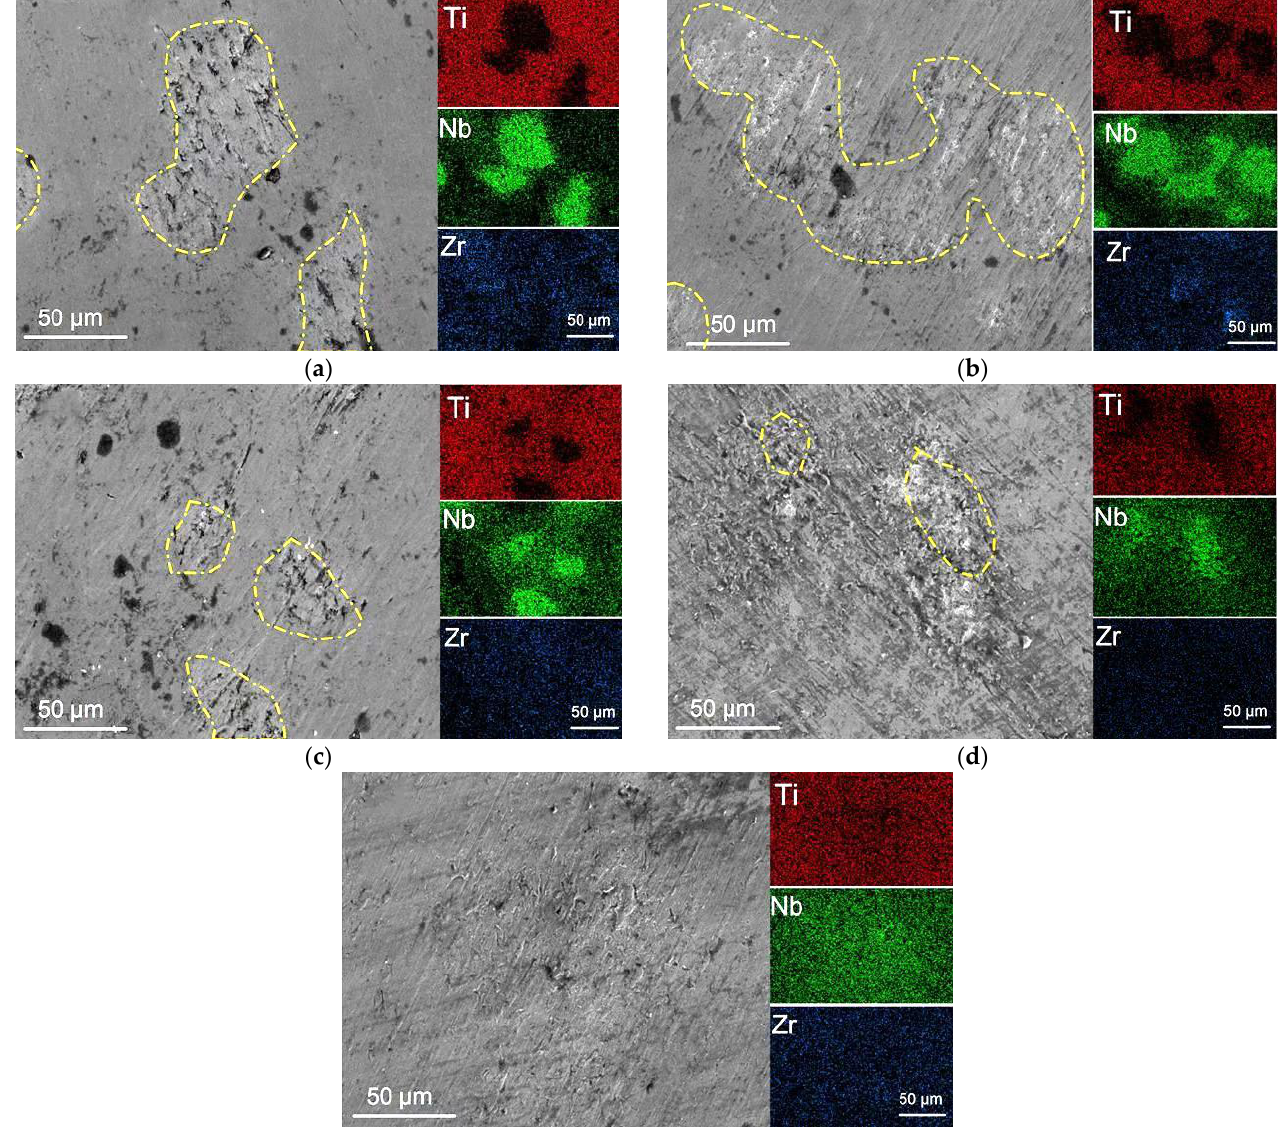
Figure 7. SEM images and EDS mapping of Ti-25Nb-6Zr sintered at different temperatures: ( a ) 1223 K, ( b ) 1323 K, ( c ) 1423 K, ( d ) 1523 K, and ( e ) 1623 K.